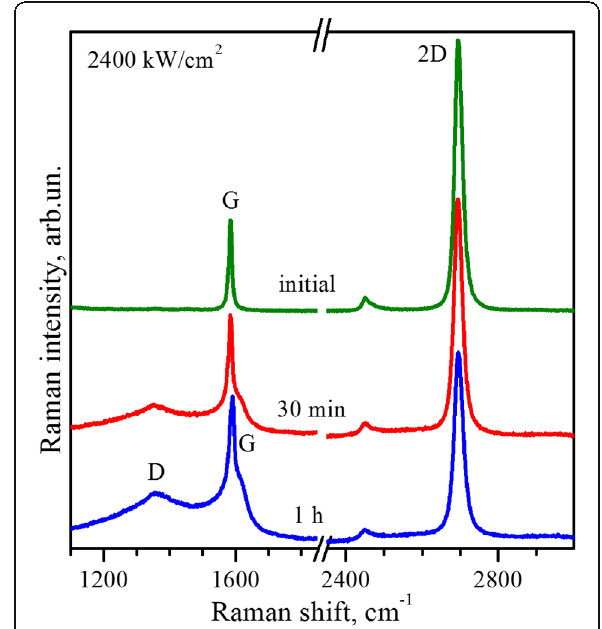
Fig. 5 Raman spectra. Raman spectra of the single-layer graphene before and after exposure by 488-nm laser line with power of 1600 kW/cm 2 . Spectra are normalized to the intensity of the G bands